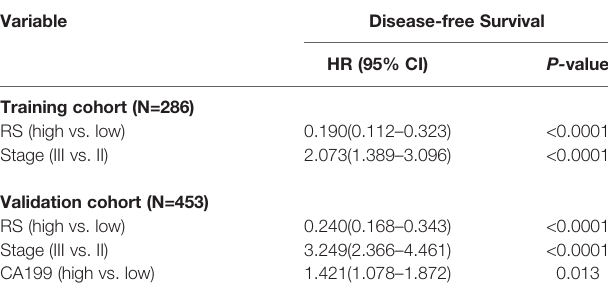
TABLE 2 | Multivariable cox regression analysis of radiomics signature (RS), TNM stage, and survival in the training and validation cohorts.